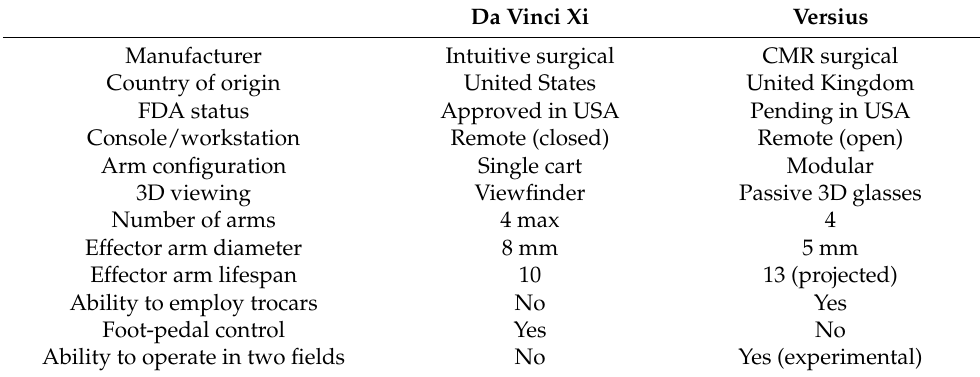
Table 2. Differences between da Vinci and Versius robotic surgical platforms.